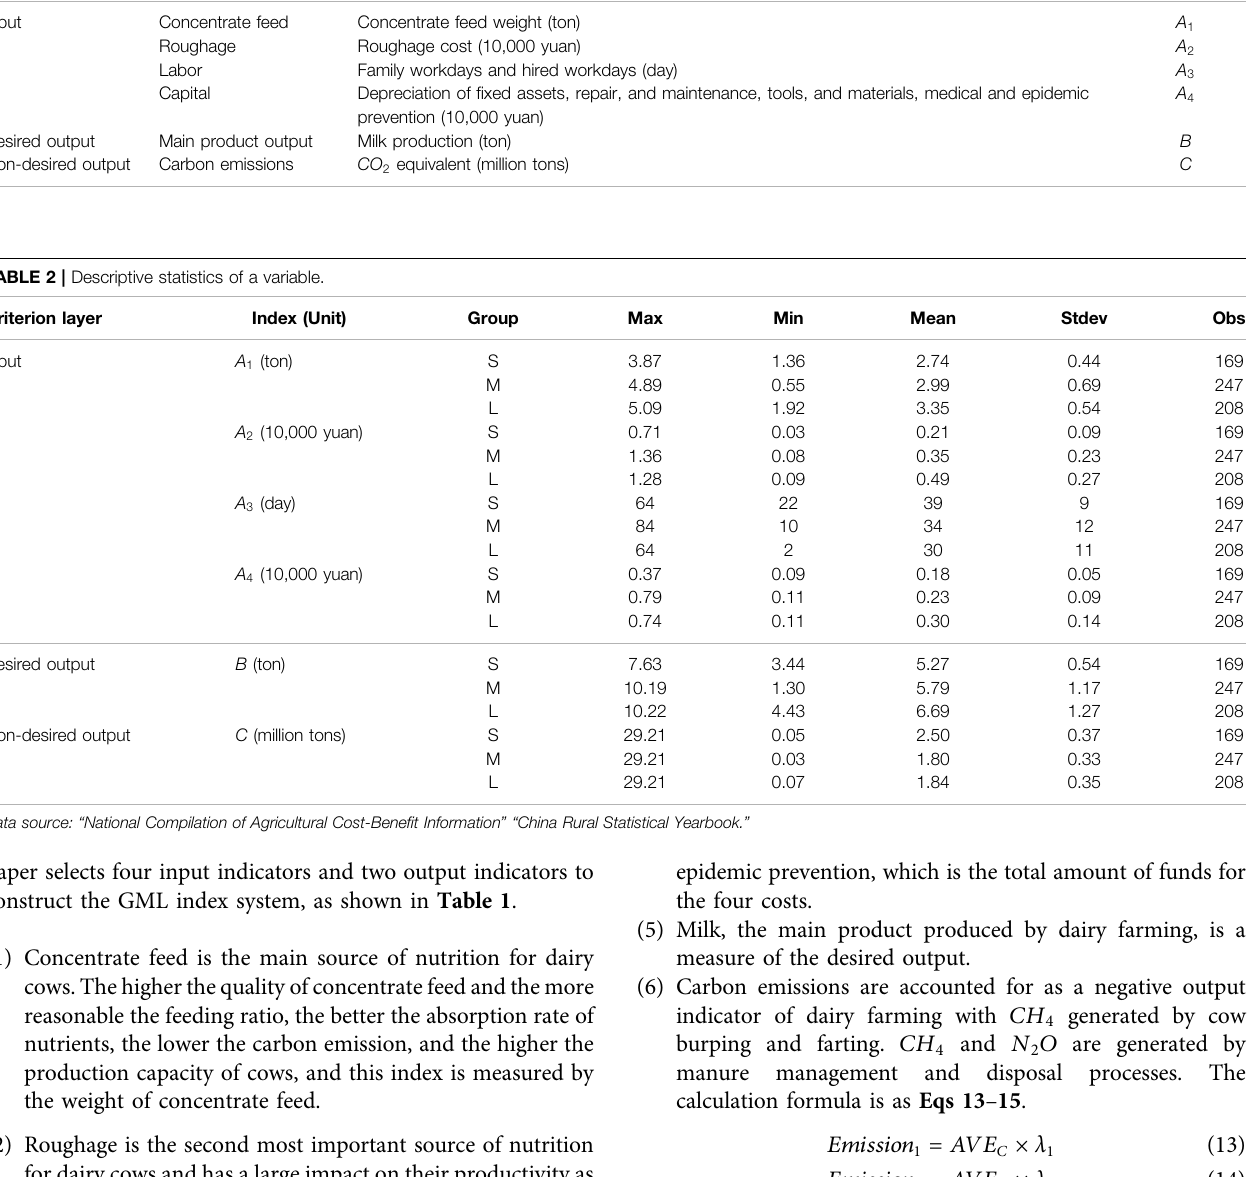
TABLE 1 | GML indicator system. First-level indicators